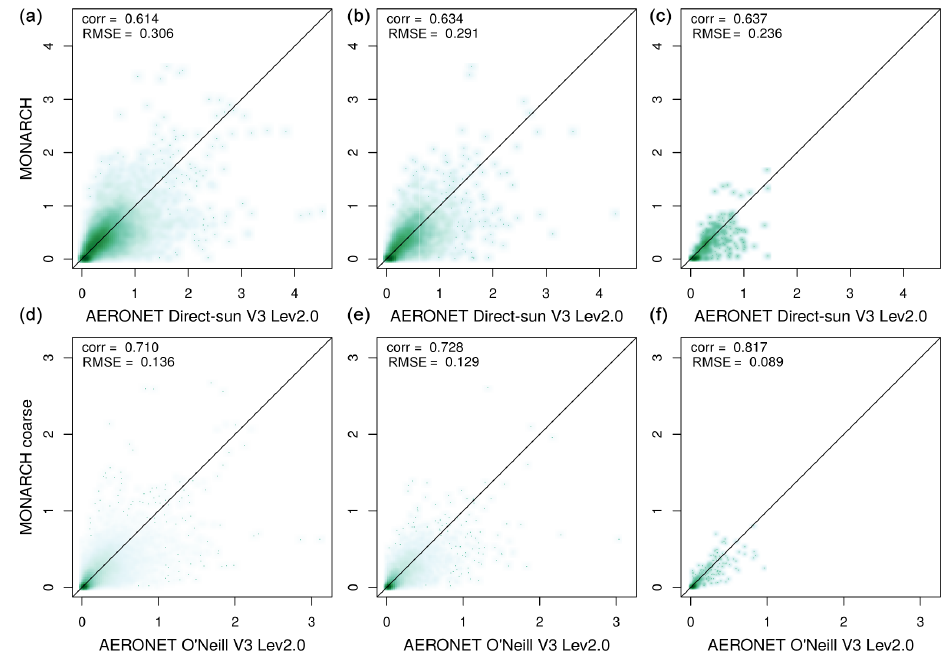
Figure 9. (a–c) Scatter plots of 3-hourly, daily, and monthly DOD estimated from AERONET direct-Sun V3 level 2.0 (AE < 0 . 3) and total DOD from MONARCH (average across runs) averages for the stations listed in Appendix C; panels (d–f) are the same as (a–c) but for AERONET O’Neill V3 level 2.0 and coarse (diameters 1.2–20µm) MONARCH DOD. The Pearson correlation coefficient (corr) and RMSE are given in the